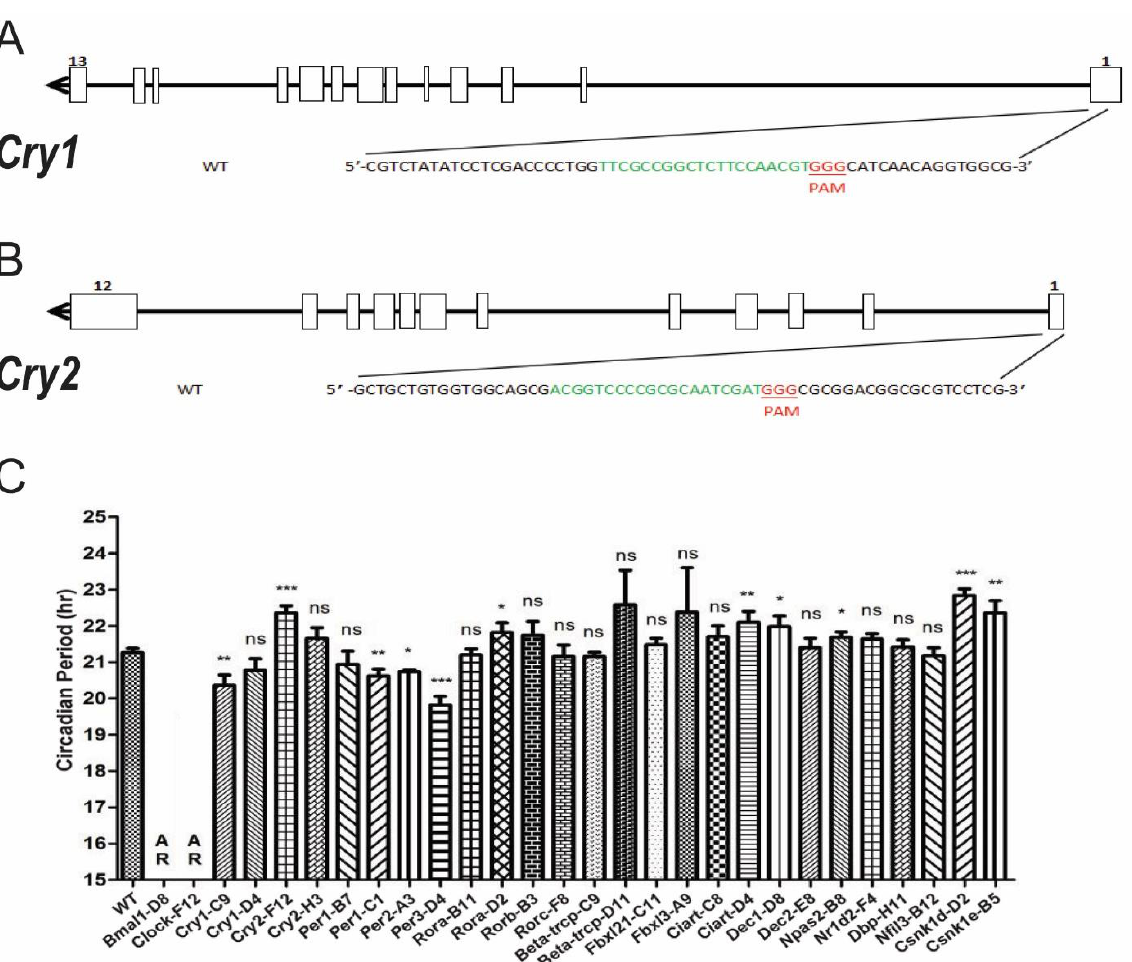
Figure 3. Circadian period phenotypes of cell lines with individual clock gene being knocked out. ( A ) The schematic diagram of sgRNA designed to knock out the Cry1 gene in NIH3T3 cells. ( B ) The schematic diagram of sgRNA designed to knock out the Cry2 gene in NIH3T3 cells. ( C ) The statistical results of the circadian period of the monoclonal cell lines for the clock genes in this study. Similar to the animal studies, Cry1 deletion cell lines showed shortened period, while Cry2 deletion cell lines showed lengthened period. The period changes were summarized in Table 1. Results are expressed as mean ± SD, n ≥ 3 for each group. ns, no significant, * p < 0.05, ** p < 0.01, *** p < 0.001.